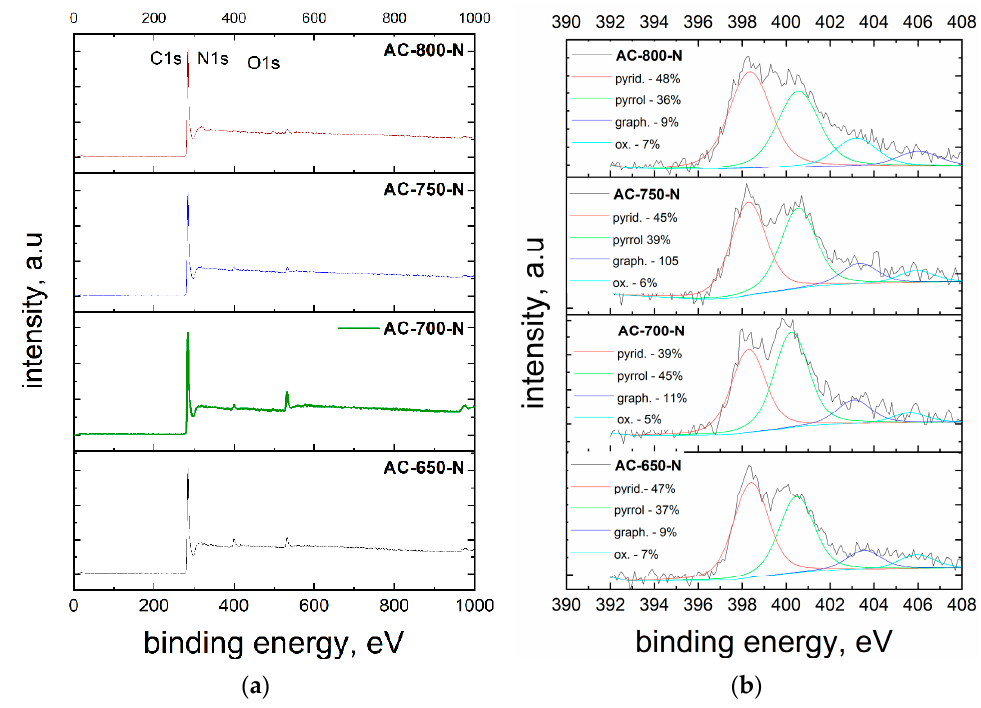
Figure 2. XPS study of nitrogen-doped, wood-based activated carbons synthesized at various temperatures. ( a ) XPS survey of samples under study; ( b ) deconvoluted high-resolution N1 spectra of samples under study and the relative content of various nitrogen-related peaks.